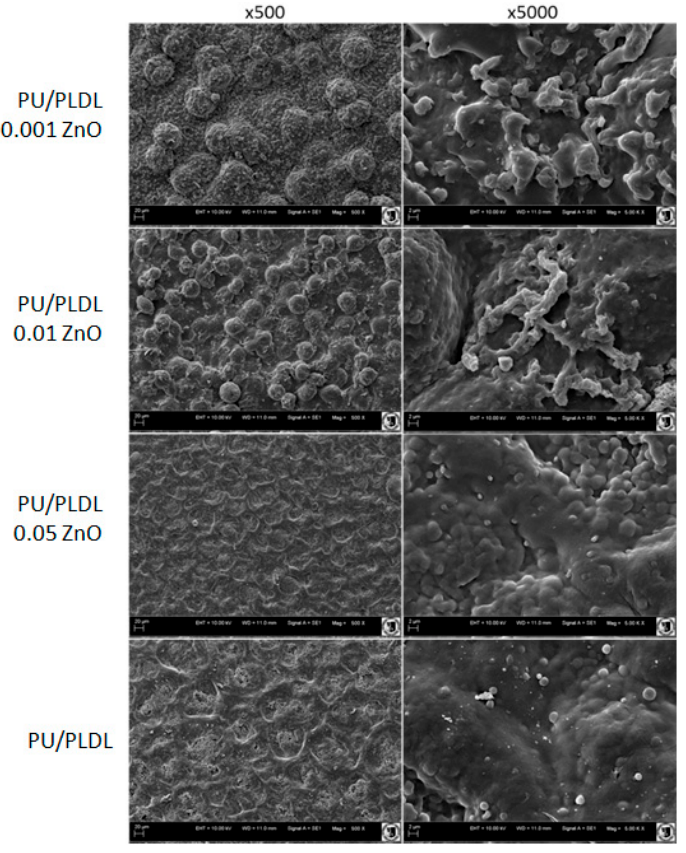
Figure 1. SEM images of PU/PLDL blend doped with different ZnO concentrations. Magnifications 500x (left column) and 5000x (right column).